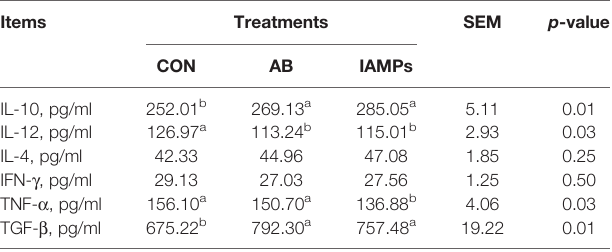
TABLE 5 | Effects of IAMPs on serum in fl ammatory factors of weaning piglets.